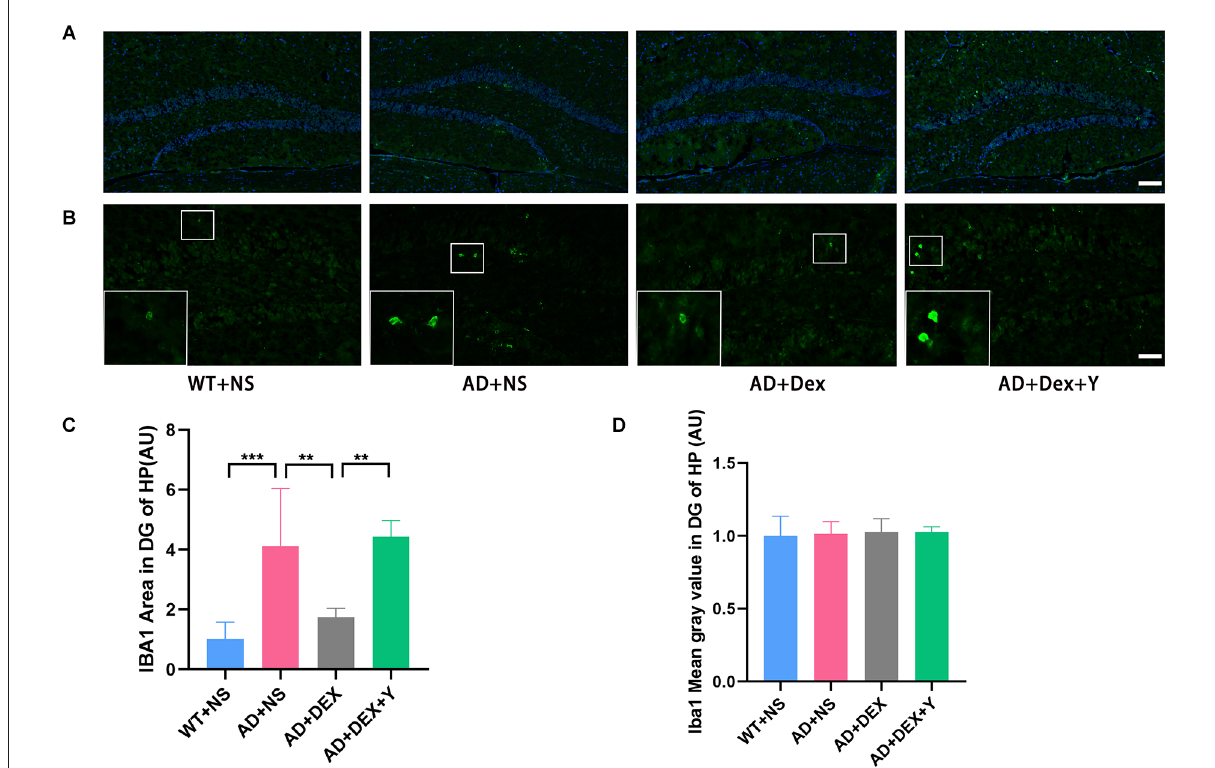
FIGURE5 Dexmedetomidine inhibited glial cell activation in the hippocampus DG of 5xFAD mice (means ± SD, ANOVA, ** p < 0.01, *** p < 0.001). (A) Representative images of IBA1-positive staining in the hippocampus DG from WT and 5xFAD mice, scale bars, 100 µ m. (B) High magnification images of IBA1-positive staining in the hippocampus DG from WT and 5xFAD mice, scale bars, 50 µ m. (C,D) The bar graph represents IBA1 expression levels in the hippocampus DG ( n = 6 in each